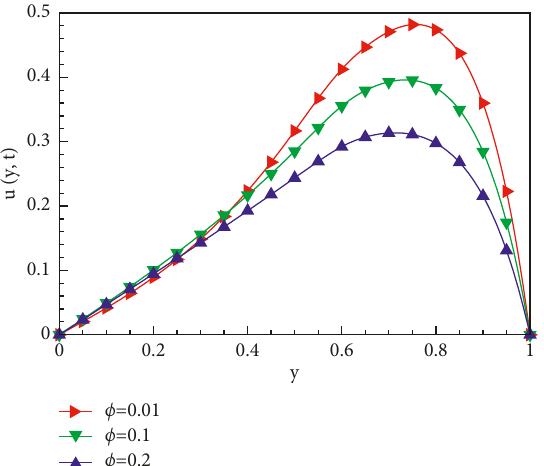
Figure 6: Influence of ϕ on u when α � β � 1 , λ α